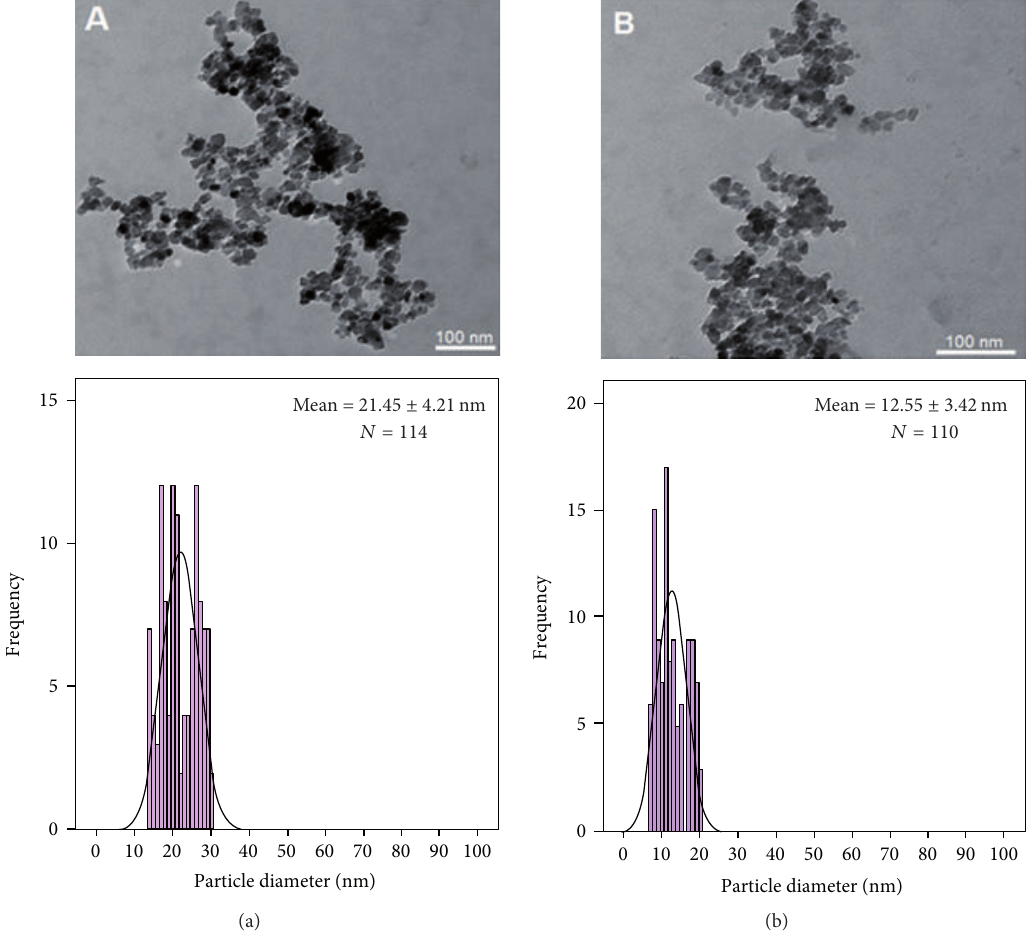
F 4: Transmission electron microscopy images and the particle size distributions for samples A and B of TNPs ((a) and (b)).